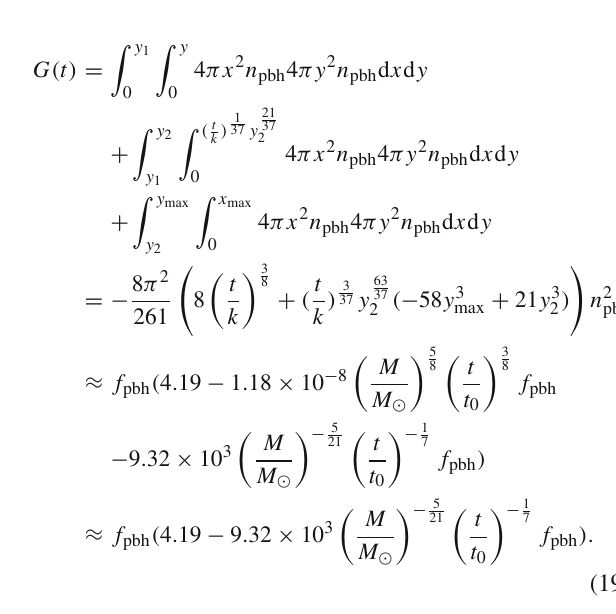
Fig. 2 Schematic illustration on calculating G ( t